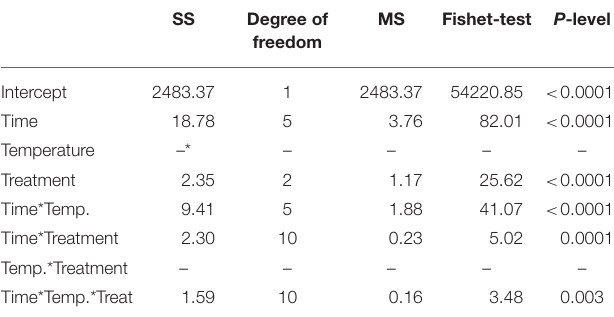
TABLE 4 | Standardized effects of treatment (addition of GF or CF), duration of storage (time) and storage temperature on the viable count of B. infantis